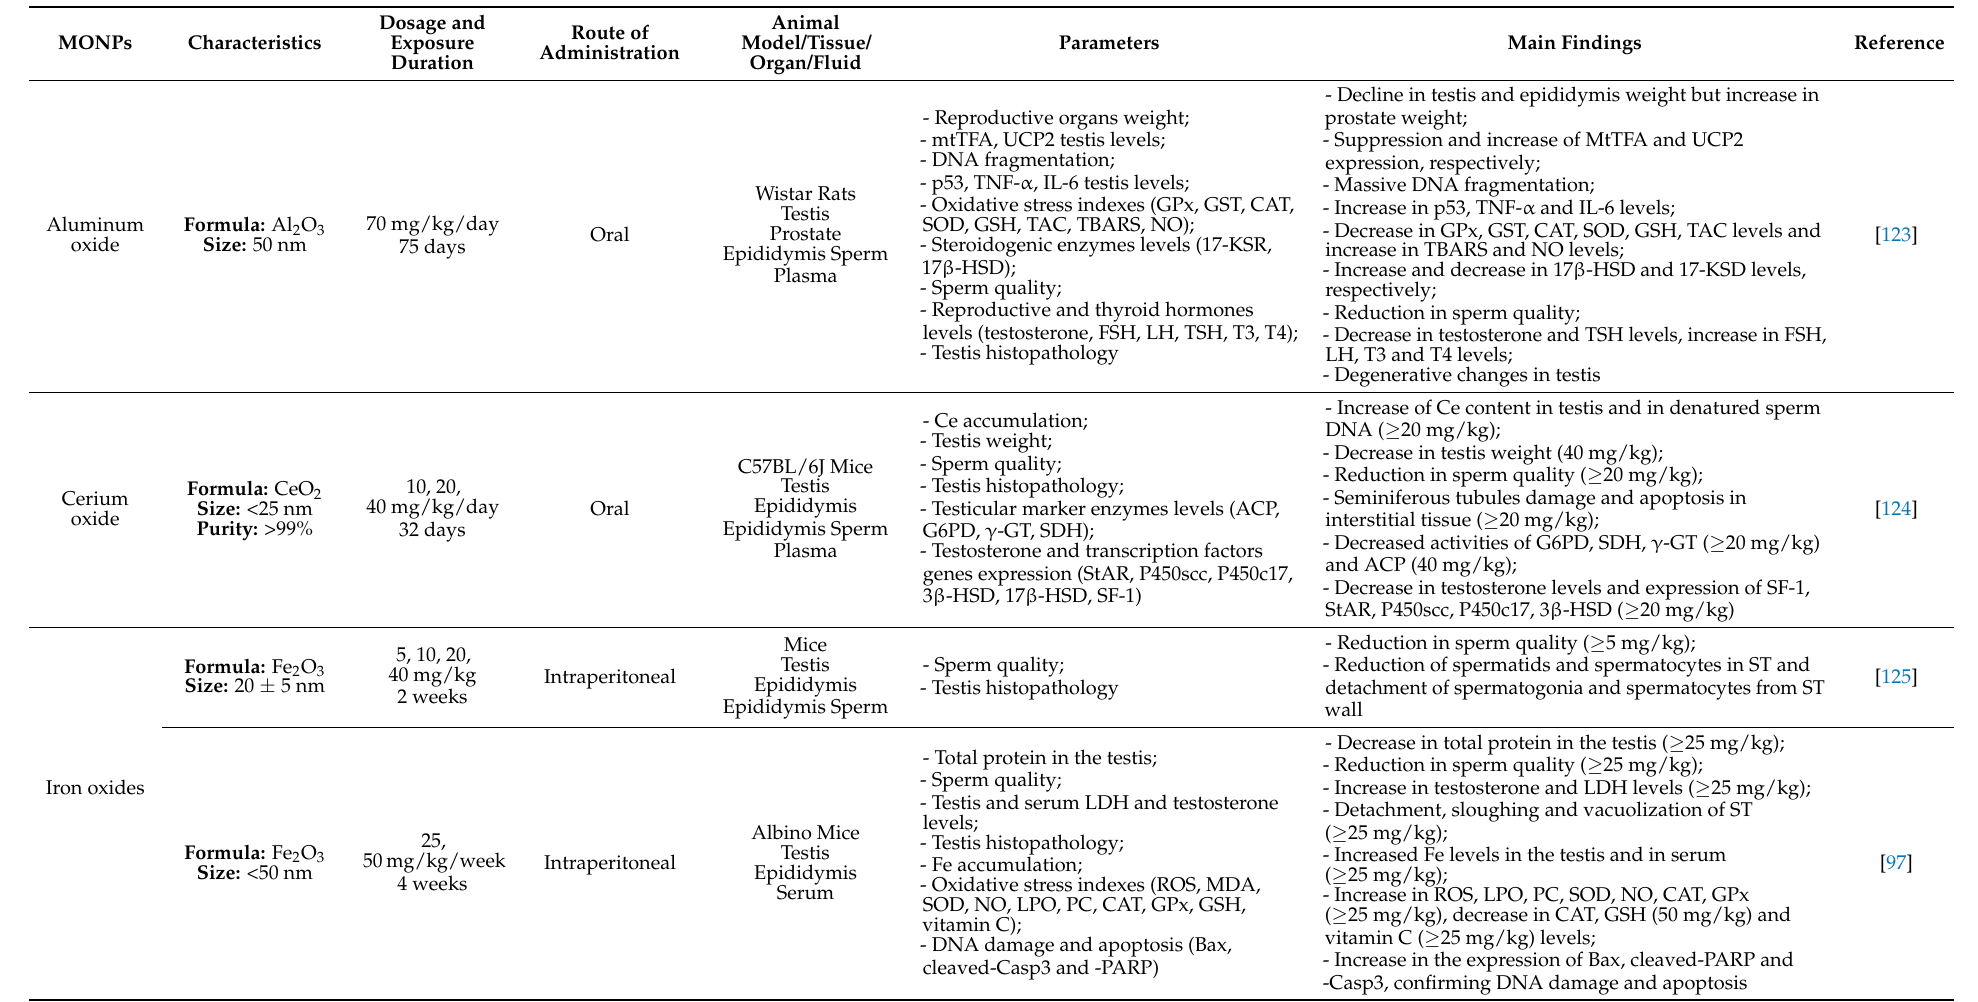
Table 2. In vivo studies of adverse effects of MONPs on the mammalian male reproductive system. The conditions where the main findings were observed are indicated in brackets.